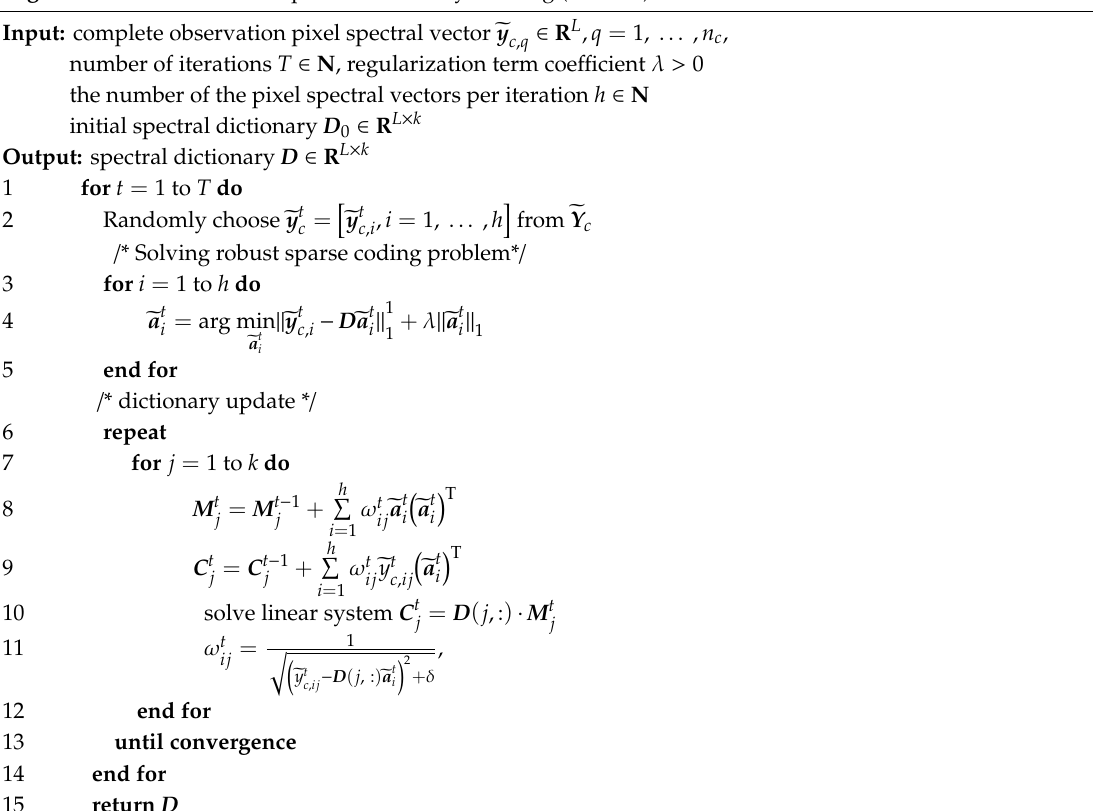
Algorithm 1: Online robust spectral dictionary learning